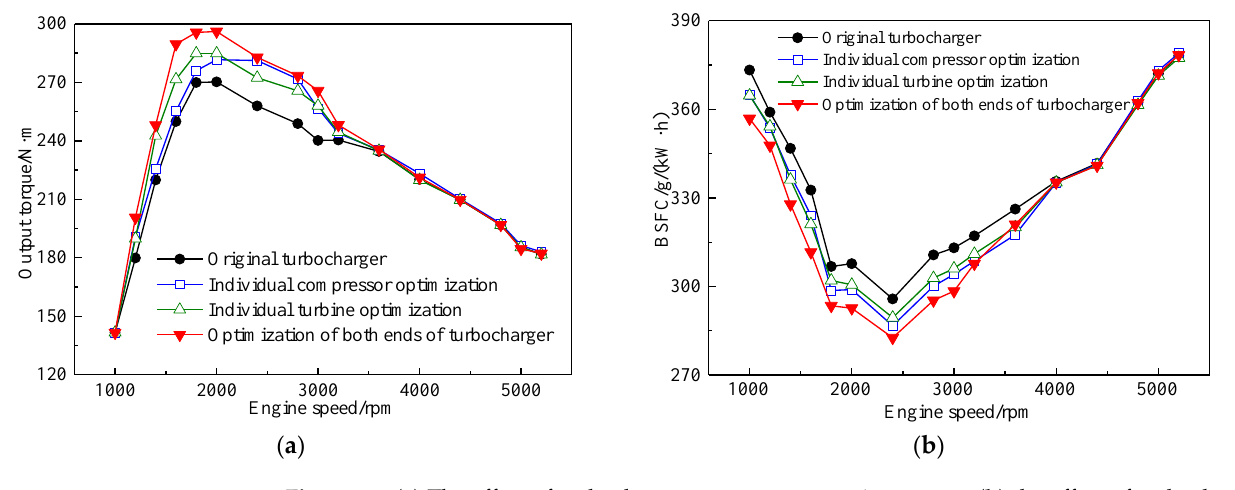
Figure 16. ( a ) The effect of turbocharger structure on engine torque; ( b ) the effect of turbocharger structure on engine BSFC.